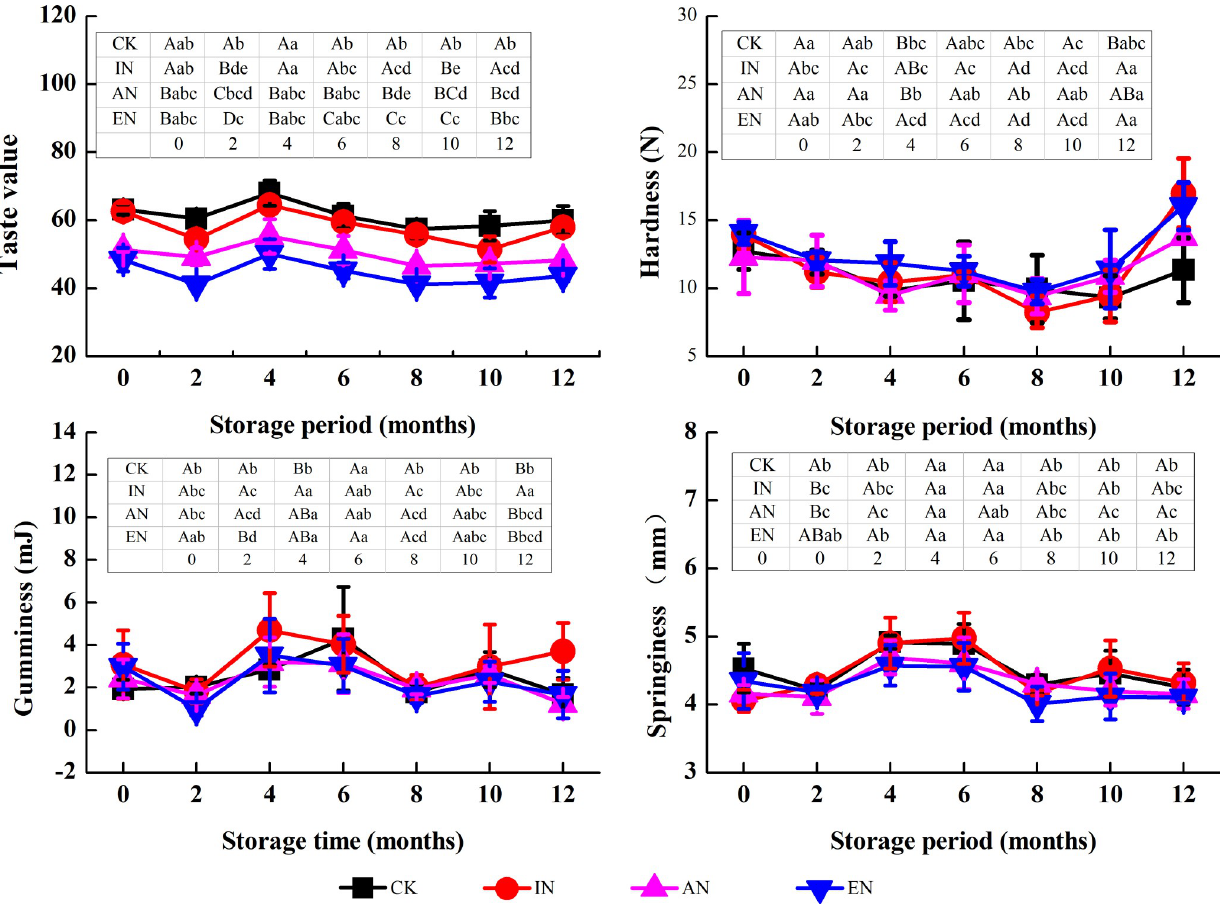
Fig 4. The changes in the eating quality of rice during storage, following the different nitrogen application rates. CK, control group (0 kg N/ha); IN, insufficient nitrogen (160 kg N/ha); AN, adequate nitrogen (260 kg N/ha); EN, excessive nitrogen (420 kg N/ha). For each parameter, the mean ± standard deviation (n = 3) followed by different lowercase letters in the same rows differ significantly as a function of storage time (Duncan’s test; p < 0.05). Different uppercase letters in the column denote significant differences as a function of different nitrogen application rates (p < 0.05).